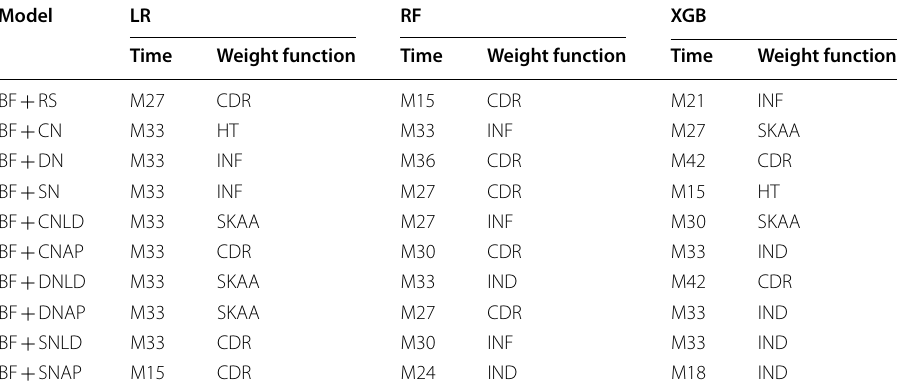
CDR refers to the weight function class-degree ratio, HT refers to the hyperbolic tangent, IND refers to the inverse degree, INF refers to the inverse frequency, and AA refers to the Adamic and Adar